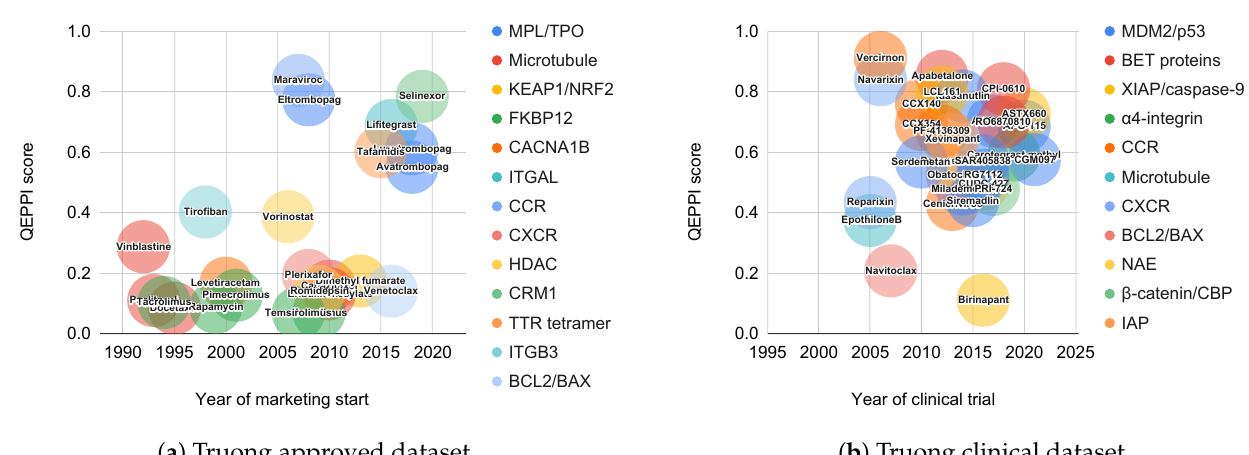
Figure 6. QEPPI scores for PPI-targeting marketed drugs within the past 30 years in Truong approved dataset and compounds in clinical trials within the past 30 years in Truong clinical dataset. QEPPI scores of PPI-targeting marketed drugs in Truong approved dataset ( a ), and QEPPI scores of PPI-targeting compounds in clinical trials in Truong clinical dataset ( b ). The color of the circle in each figure indicates the target for that drug or compound (in detail Supplemetary Table S4).